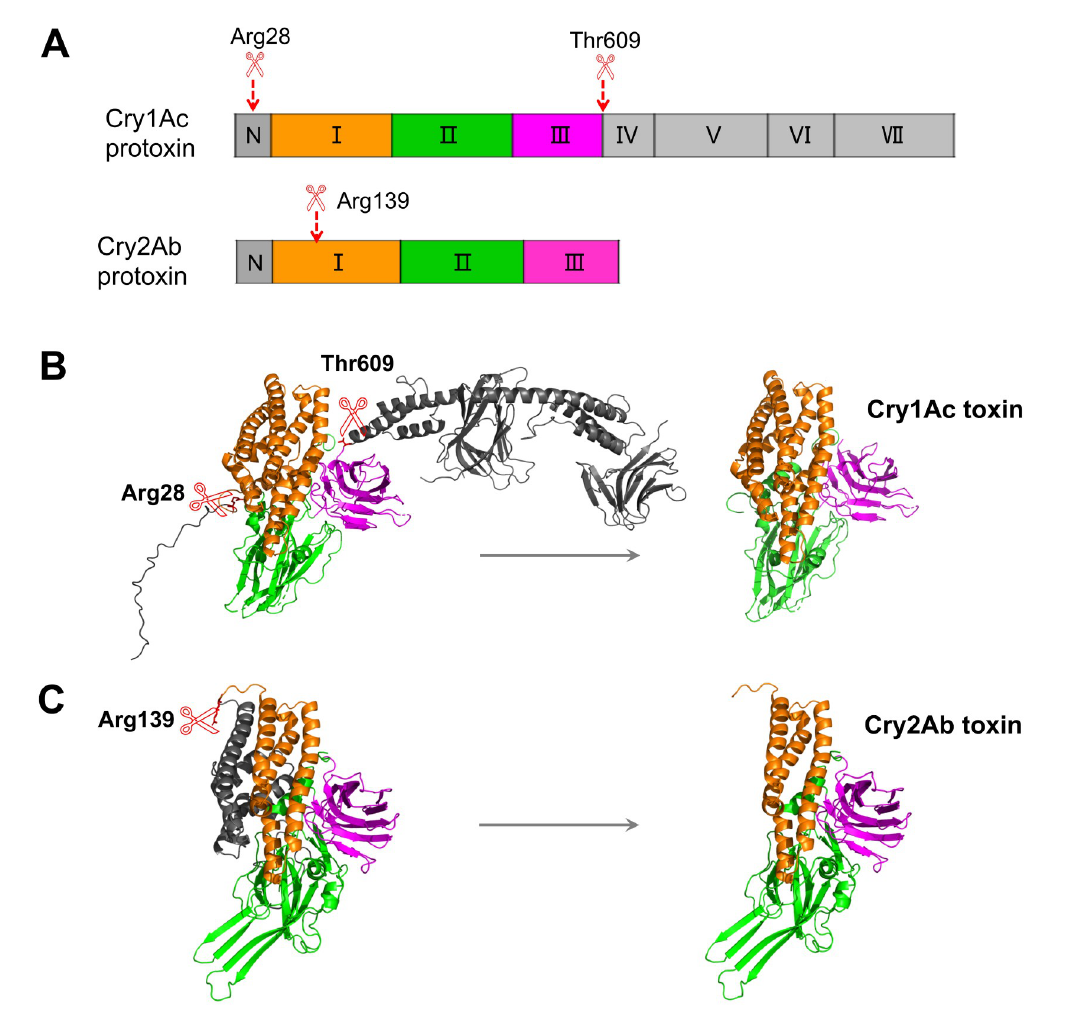
Fig 2. The structure of Cry1Ac and Cry2Ab. (A) The schematic diagram of Cry1Ac and Cry2Ab protoxins. The red dotted arrows represent cleavage sites. (B) Protein 3D structures of Cry1Ac protoxin and activated toxin. (C) Protein 3D structures of Cry2Ab protoxin and activated toxin. The three-dimensional structures of Cry1Ac and Cry2Ab protoxins were based on homologous modeling, built with SYBYL-Orchestrar software and viewed by the PyMOL program. The removed parts are shown in gray. The orange, green and purple represent domains I, II and III, respectively. Arg28 and Thr609 represent the cleavage sites of protease hydrolysis of Cry1Ac protoxin from the N- and C-termini, and Arg139 represents the cleavage sites of Cry2Ab from the N-terminus.